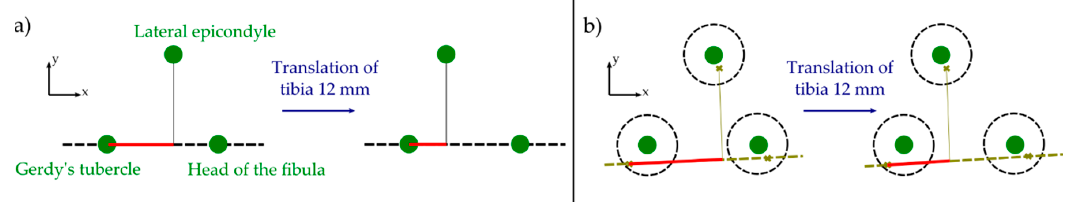
Figure 5 . ( a ) AP translation as a function of the orientation angle of the camera with respect to the sagittal plane. ( b ) AP translation as a function of the distance of the camera plane. Figure 6. Graphical representation of the calculation of AP translation ranges (as mentioned in Section 2.3). ( a ) Calculation of AP translations without deviations (from green dots). ( b ) Calculation of AP translations with deviations (from yellow ticks).